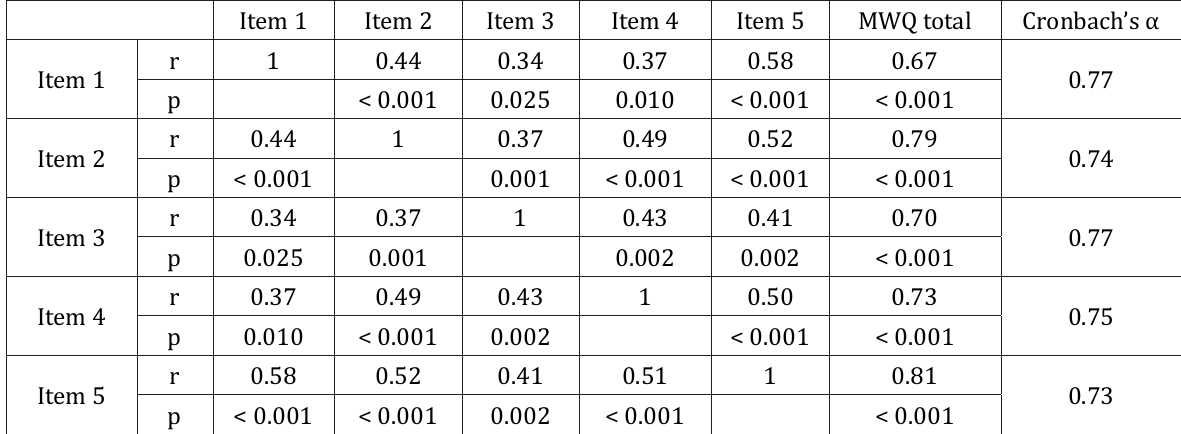
Table 3. Inter-correlations between individual MWQ scale items and total score. The right column additionally shows Cronbach’s α for each item and MWQ overall outcome.